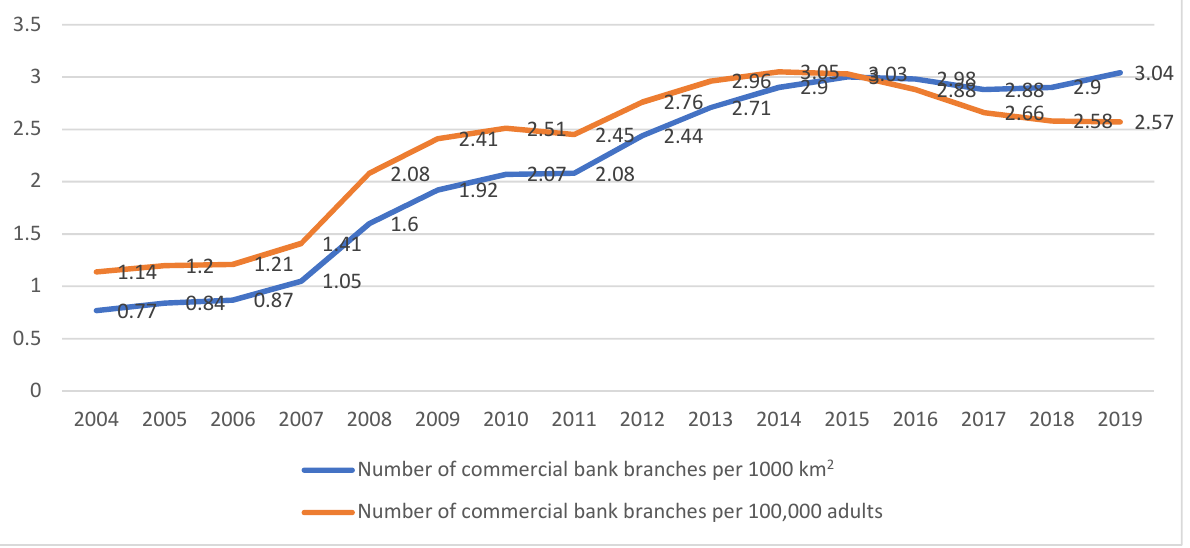
Depositors increased from 1.2 million in 2004 to 6.8 million in 2019. Deposit accounts with commercial banks grew from 1.2 in 2004 to 12.8 million in 2019. The highest increases in depositors and deposits took place in 2008 (43%) and 2017 (51%). Mokash was